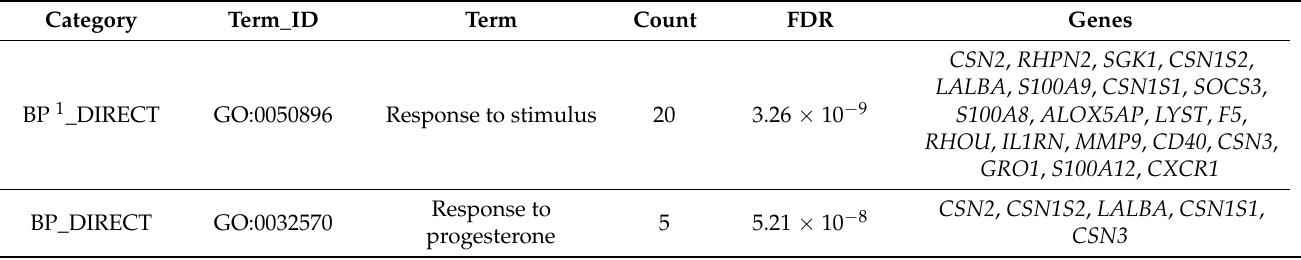
Table 4. Top significant gene ontology (GO) terms enriched using genes associated with mastitis in dairy